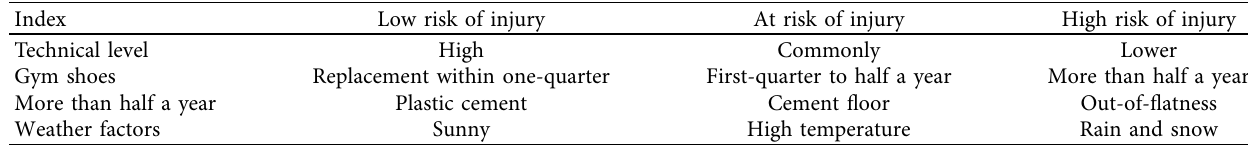
Table 2: Risk assessment of external injury factors.